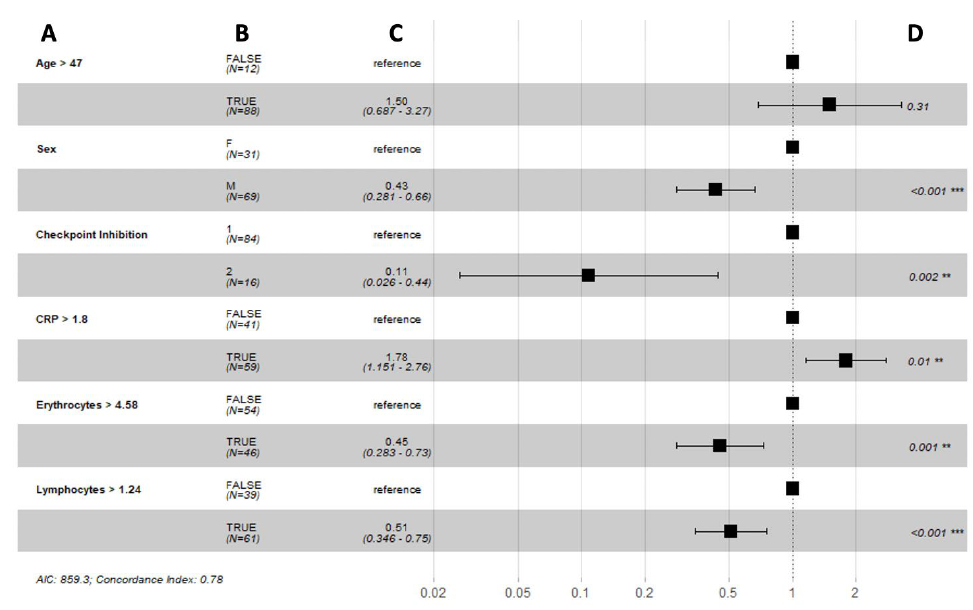
Figure 8. Forest plots summarizing the results of a Cox proportional hazard model analysis of progression-free survival with optimal cut-off values of time-varying covariates: ( A ) variable; ( B ) number of patients; ( C ) hazard ratio (95% CI); ( D ) p -value. Abbreviations: F = female, M = male, 1 = single ICI, 2 = double ICI, CRP = c-reactive protein, AIC = Akaike information criterion. ** and *** indicate significance at the 0.05 and <0.01 levels retrospectively.